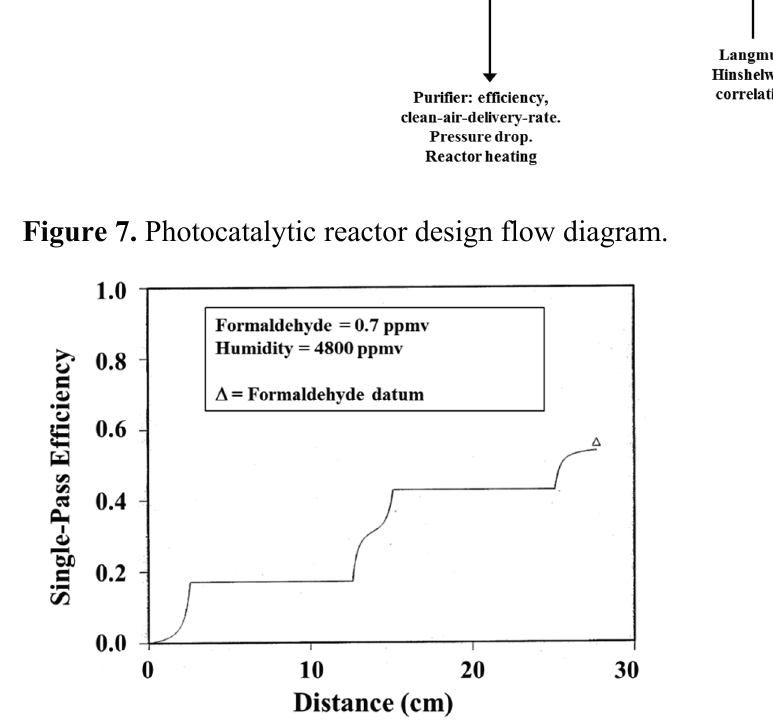
Figure 8. Comparison of model and experiment for formaldehyde in a 2-UV